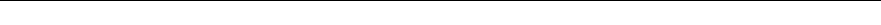
Figure 3. UNC’s “Real Food” Percentage Since the Beginning of the Auditing Process Prior to February 2014, the audit was only conducted for the month of September. Percentages correspond to the Real Food Challenge 1.1 Standards up until February 2016 (blue bars). February 2016 and forward correspond with RFC 2.0 Standards (red